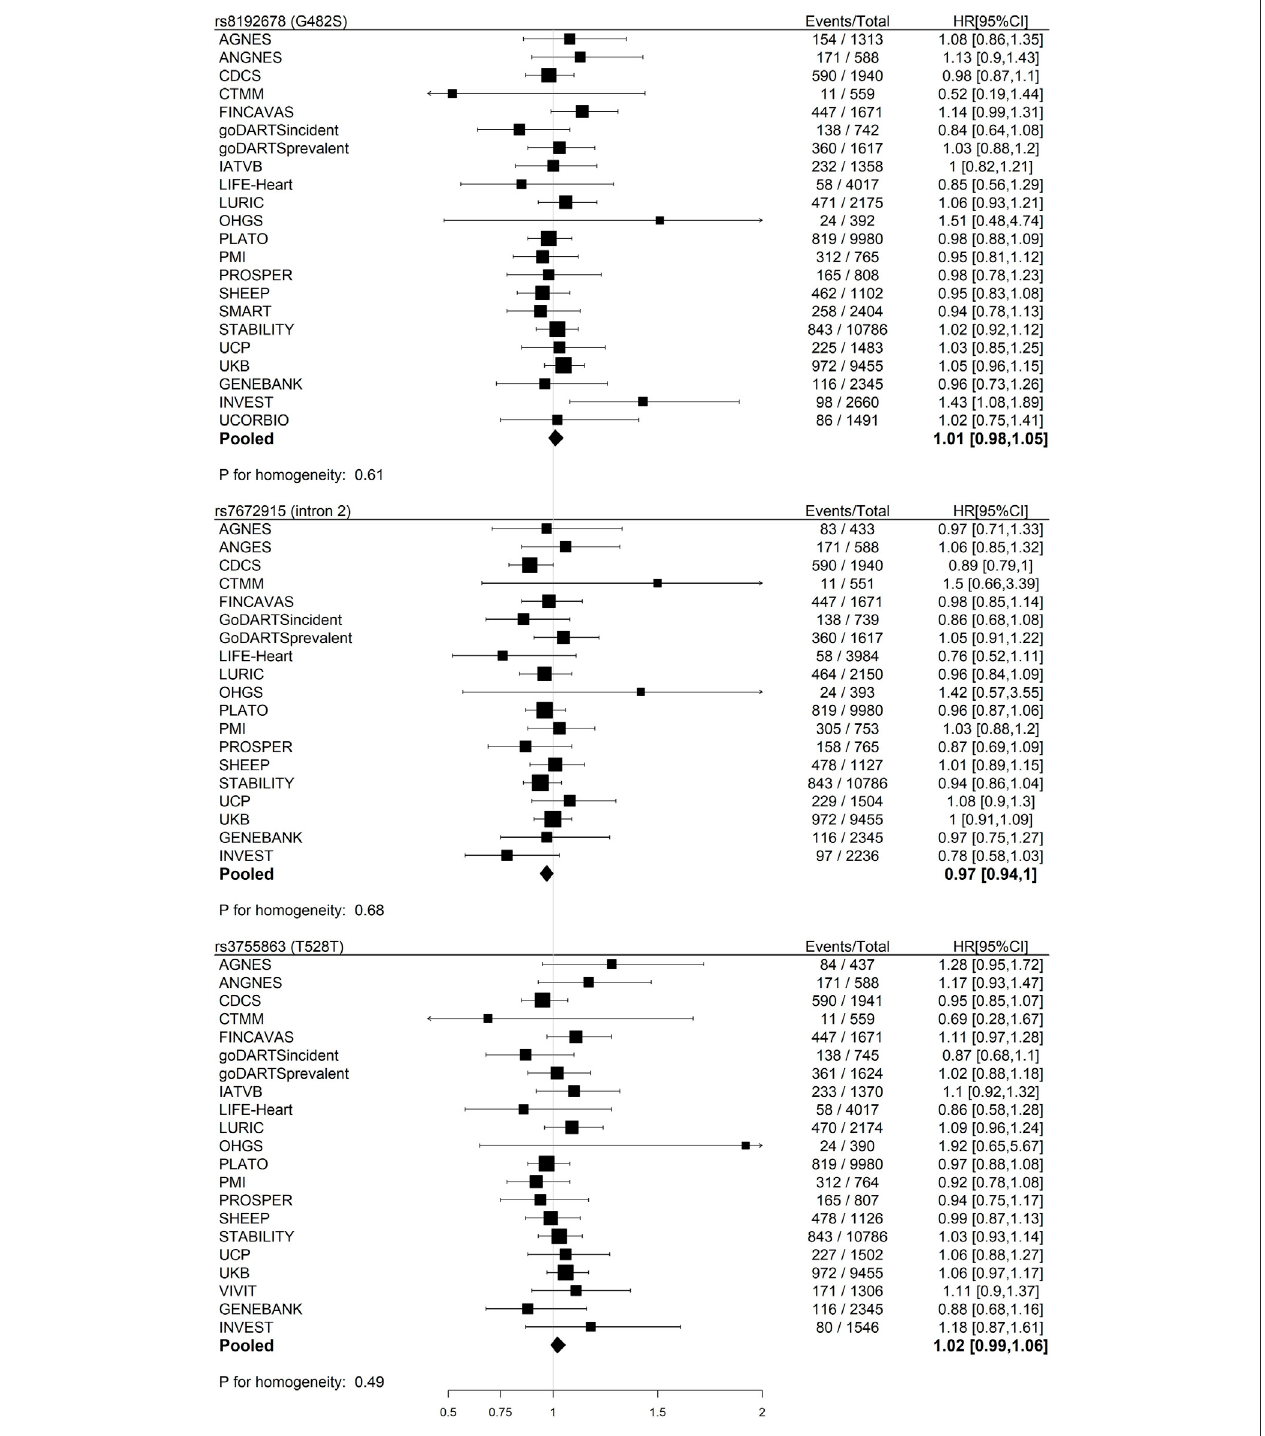
FIGURE 2 | Meta-analyses of the associations between three SNPs in the PPARGC1A gene and primary outcome (CHD death or myocardial infarction) in participants with baseline CHD within GENIUS-CHD using an additive, fi xed-effect model adjusted for age and sex.